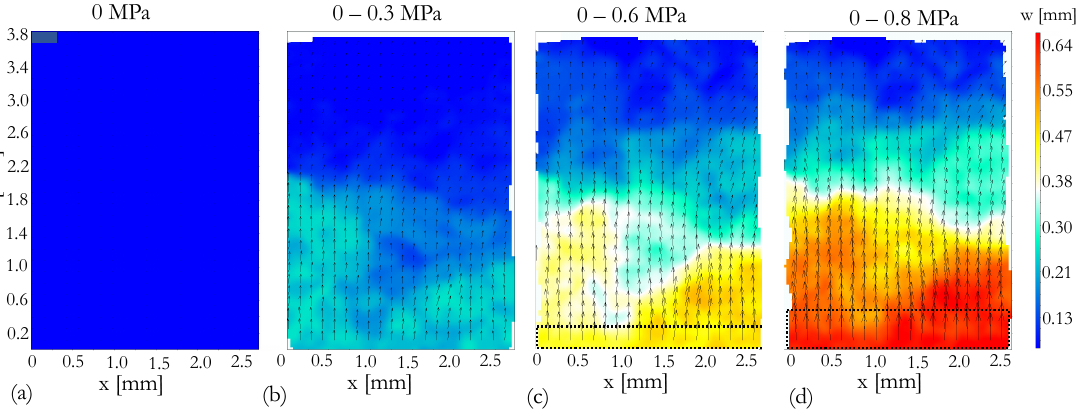
Figure 5. The DVC results for the snow sample at three loaded states, 0.3 MPa, 0.6 MPa and 0.8 MPa. w refers to the displacement in z-direction within the investigated volume. Figure 5a represents the displacement field at unloaded state. Figure 5b,c,d represent the displacement fields between unloaded state and loaded states 0.3 Mpa, 0.6 Mpa and 0.8 Mpa, respectively. Arrows indicate the direction of the displacement field and dashed black lines in Figure 5c,d represent the moving punch.